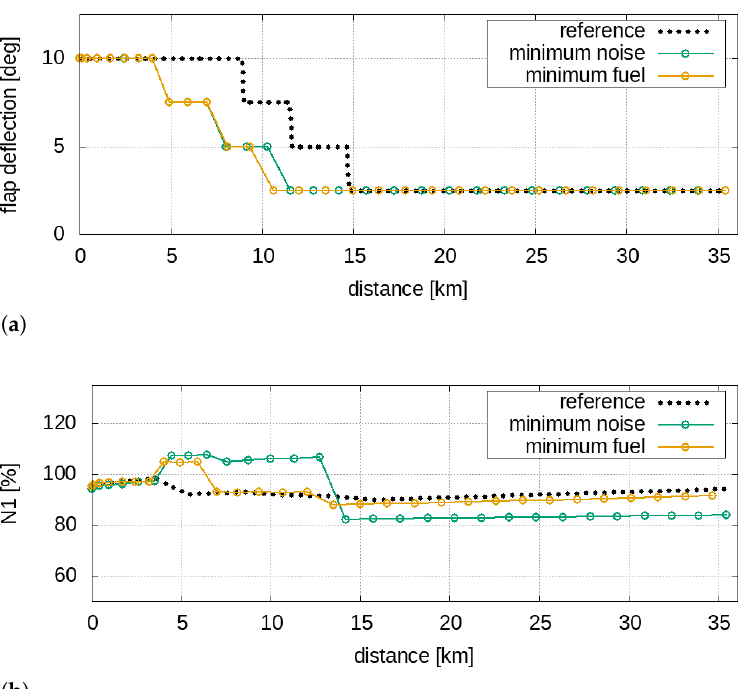
Figure 6. Takeoff manoeuvre for the single-aisle aircraft. Procedural variables. ( a ) flap